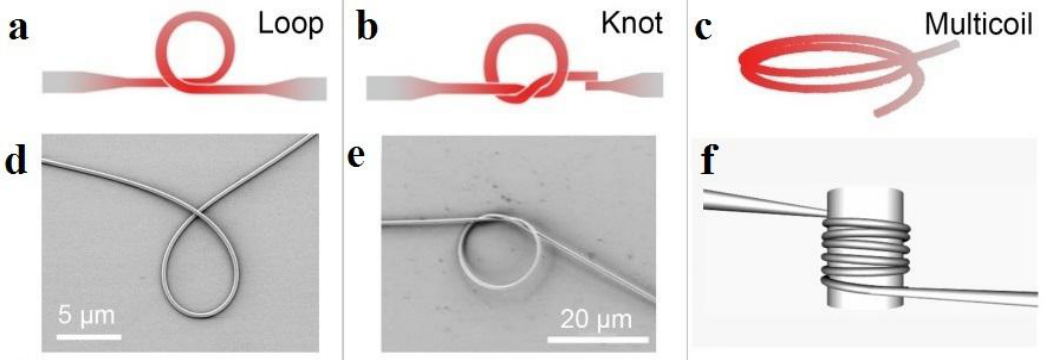
Figure 10. Optical microfiber resonators. Schematics of ( a ) loop; ( b ) knot; ( c ) multicoil resonators [3]; ( d ) SEM image of a loop resonator; ( e ) SEM image of knot resonator using a 520 nm diameter silica microfiber [9]; ( f ) Schematic of an optical-rod-wrapped microfiber multicoil resonator